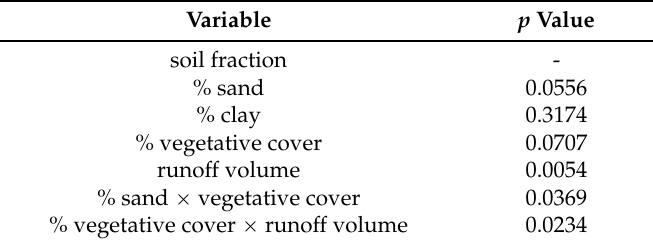
Table 3. Statistical analysis for rotavirus recovery for different soil and vegetation